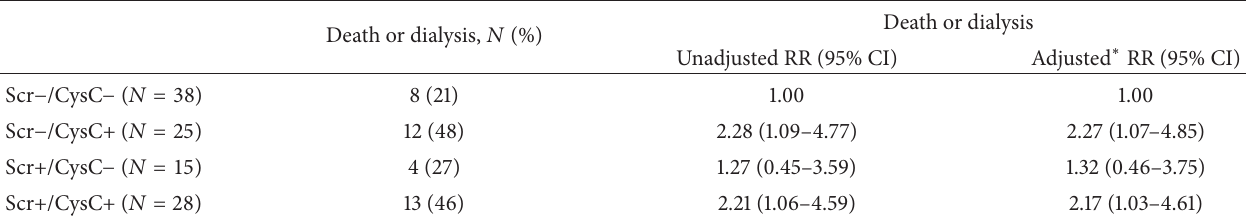
Table 3: Independent association of trends in filtration markers and the primary